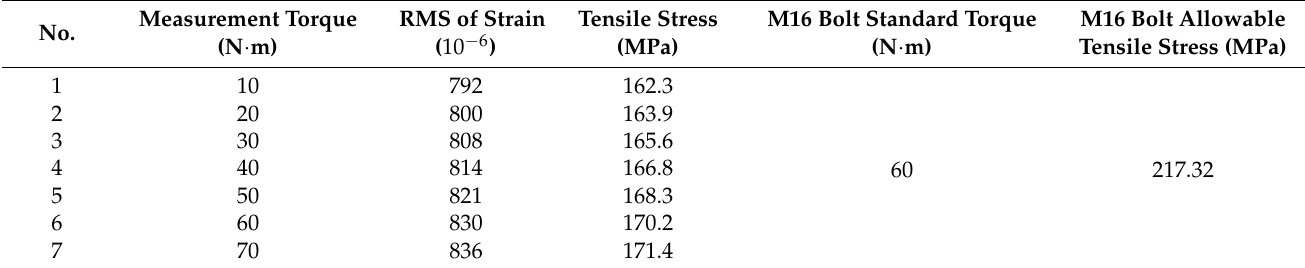
Table 3. Smart bolt strength tests.